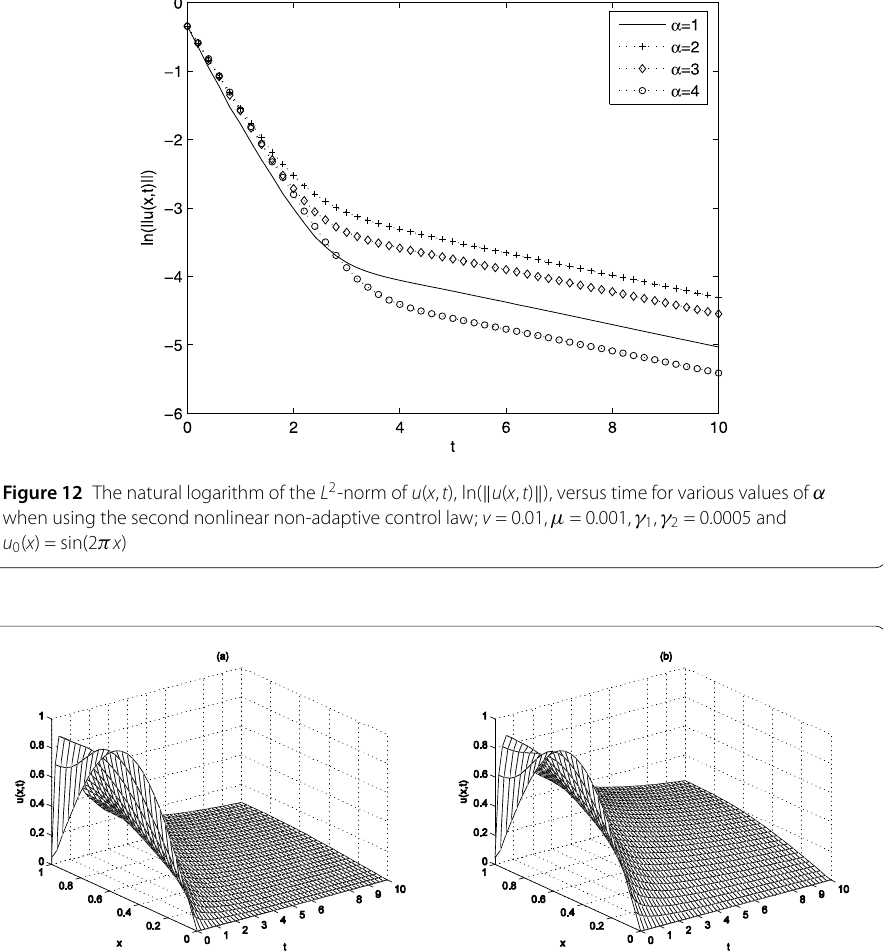
Different initial conditions u 0 ( x ) were considered in our study. In the simulations, we set the parameters v , μ , γ 1 and γ 2 to be 0.01, 0.001, 1, and 0.0005, respectively. Figures 13(a)– (d) depict a 3-d landscape of the behavior of the solution u ( x , t ) as it evolves in time when u 0 ( x ) = sin ( π x ). The L 2 -norm of u ( x , t ), (cid:7) u ( x , t ) (cid:7) , versus time and the natural logarithm of the L 2 -norm of u ( x , t ), ln ( (cid:7) u ( x , t ) (cid:7) ), versus time are presented in Fig. 14, and Fig.